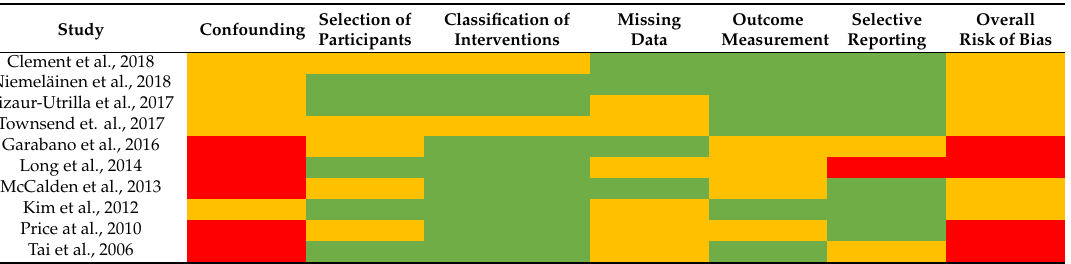
Table 4. Assessment of methodological